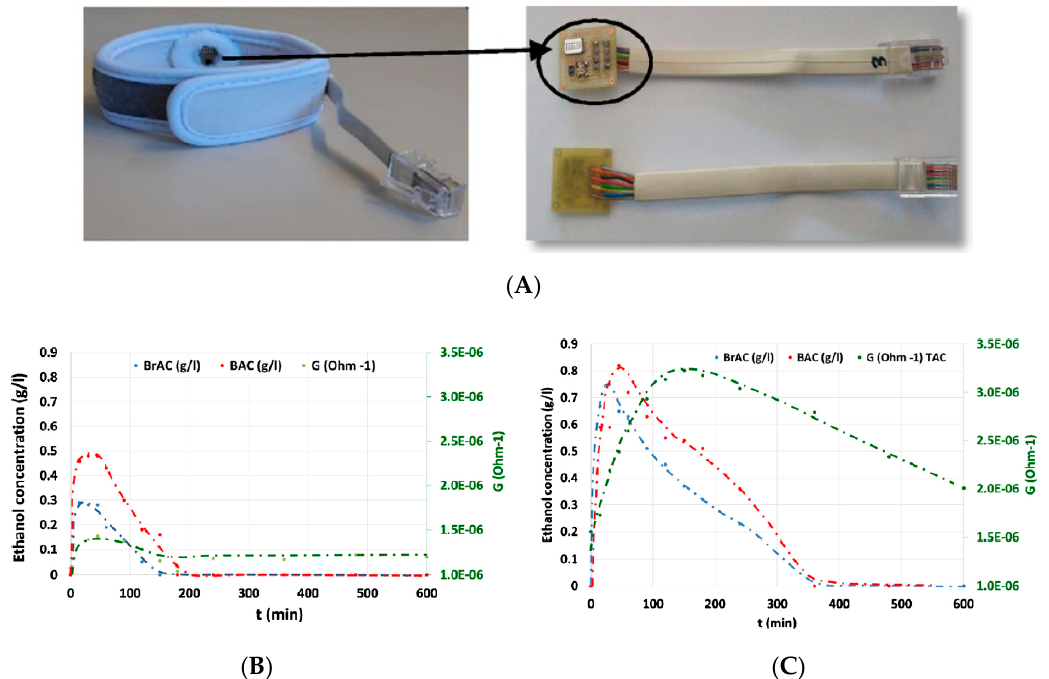
Figure 32. ( A ) Wristband carrying the SnO 2 sensor and the electronics associated to it. ( B ) Comparison of blood (BAC), breath (BrAC) and transdermal (TAC) alcohol concentration for a maximum BAC of 0.5 g L − 1 . ( C ) Comparison of BAC, BrAC, and TAC for a maximum BAC of 0.5 g L − 1 . Reproduced from